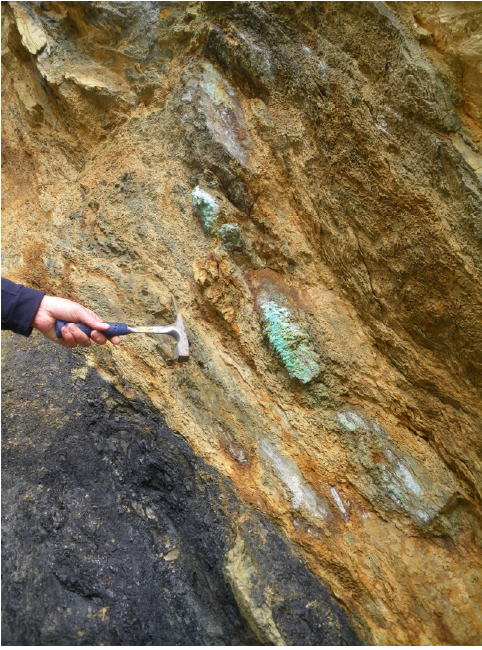
Figure 10. Avoca, County Wicklow: copper mineralisation hosted in Ordovician volcanic tuffs.